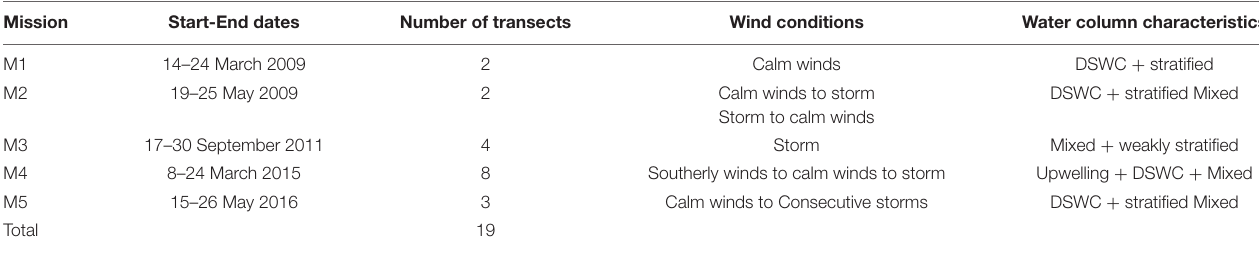
TABLE 1 | Overview of glider missions. Mission Number of